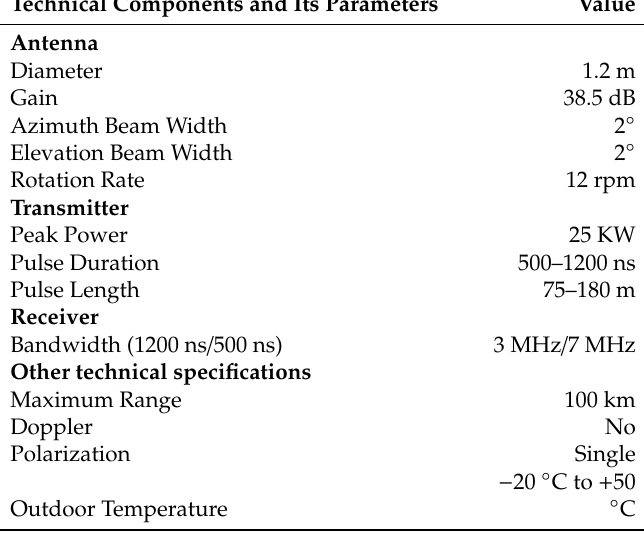
Table 1. Technical specifications of CAXX radar (Rainscanner 120, SelexGmbH). Peak Power is only available with a newly installed Magnetron. This peak value decreases slightly with time and hence is compensated by automatic internal